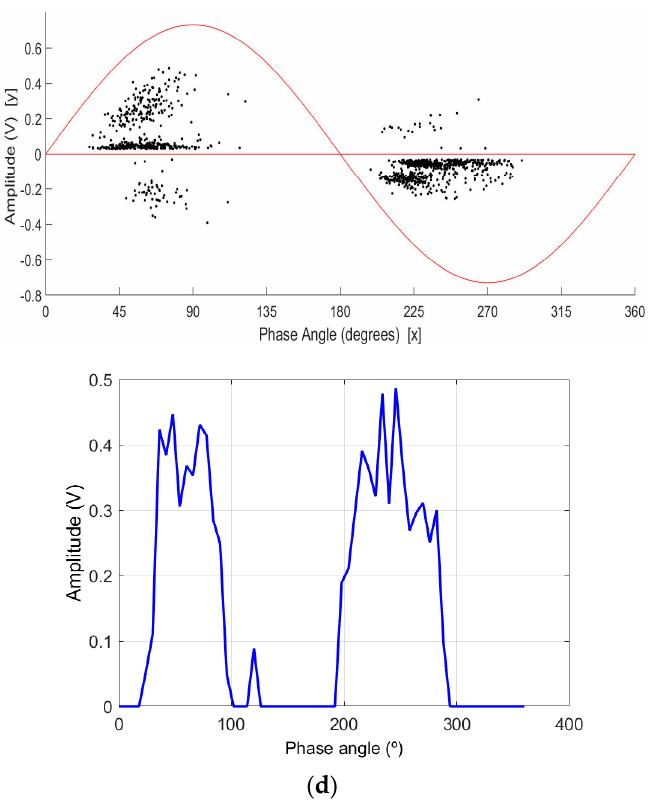
Figure 4. Phase-resolved partial discharge (PRPD) patterns and their corresponding reduced patterns for the single artificial neural network (SNN) and the ensemble-boosting algorithm (EBA) for: ( a ) Cylindrical vacuoles in methacrylate; ( b ) Point-air-plane configuration; ( c ) Ceramic bushing with contaminated surface, and; ( d ) Power Transformers (150 kVA).